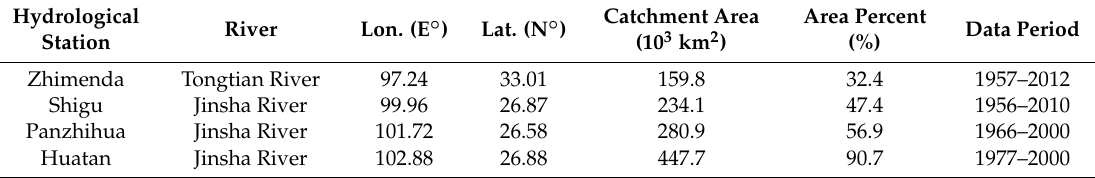
Table 1. Basic information of the 4 hydrological stations.